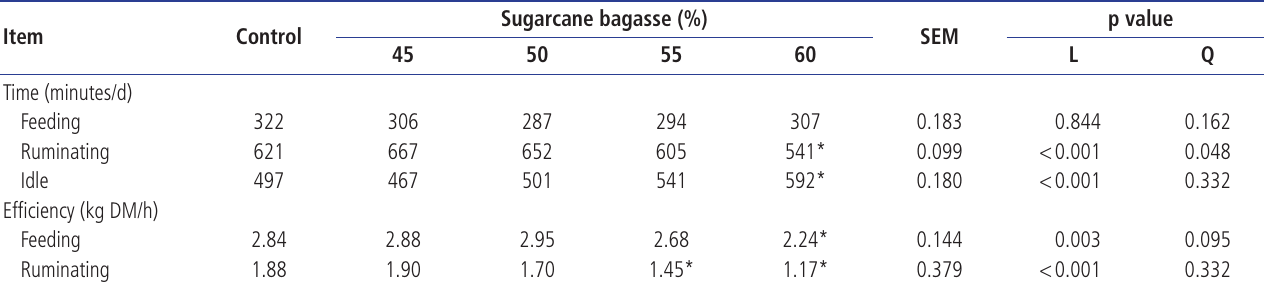
Table 4. Ingestive behavior of cows fed sugarcane bagasse Item Control